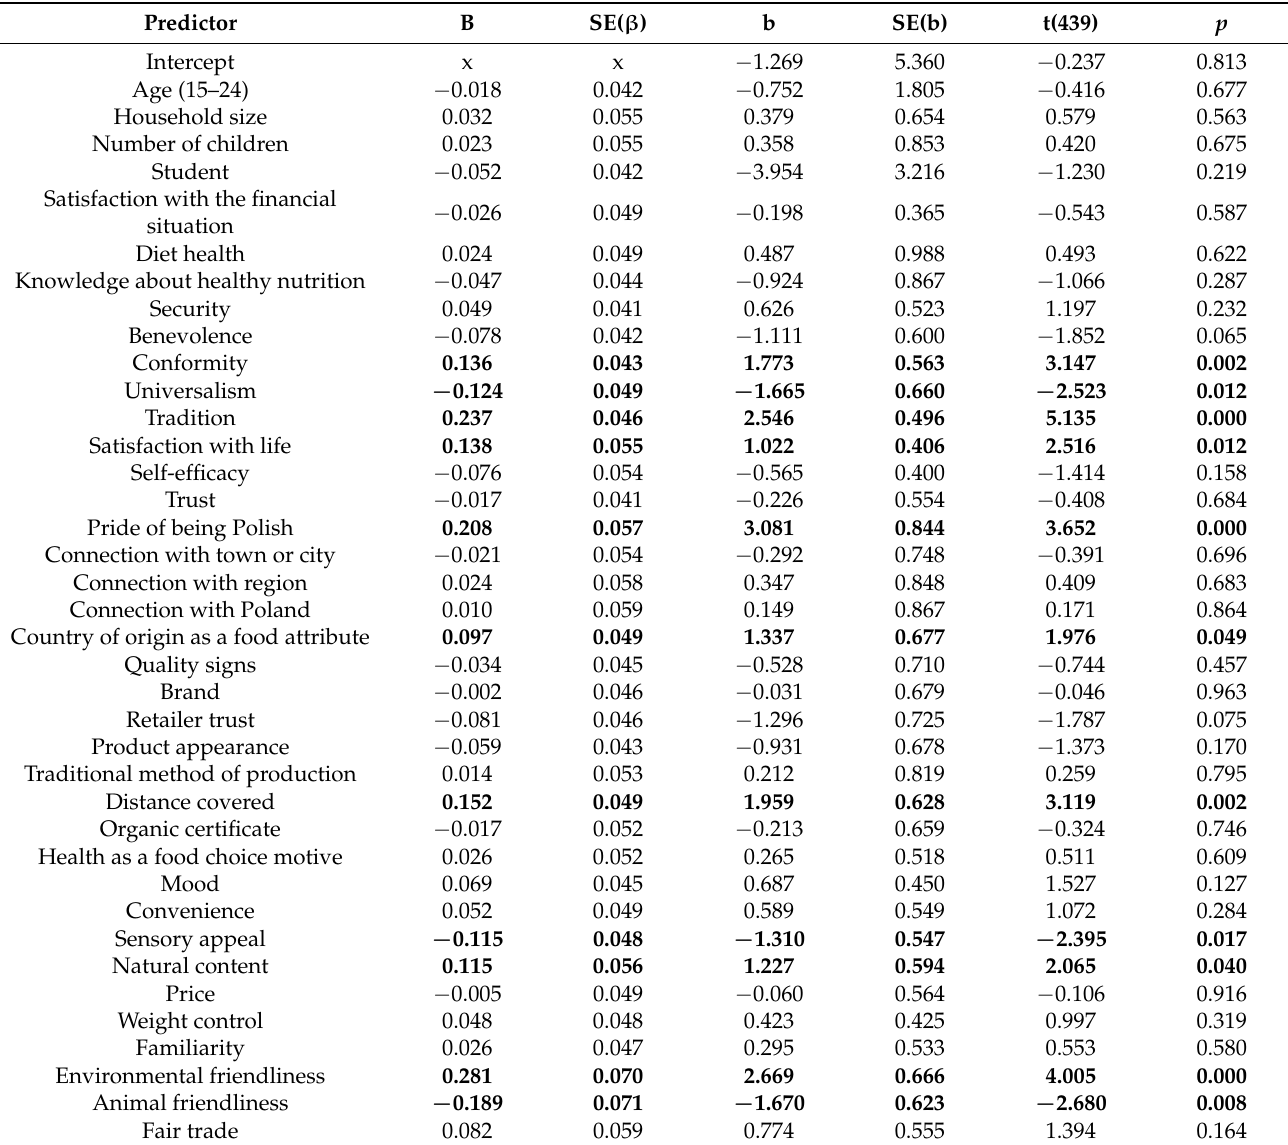
Table 6. Selected predictors of consumer ethnocentrism in the food market among men (a multiple regression